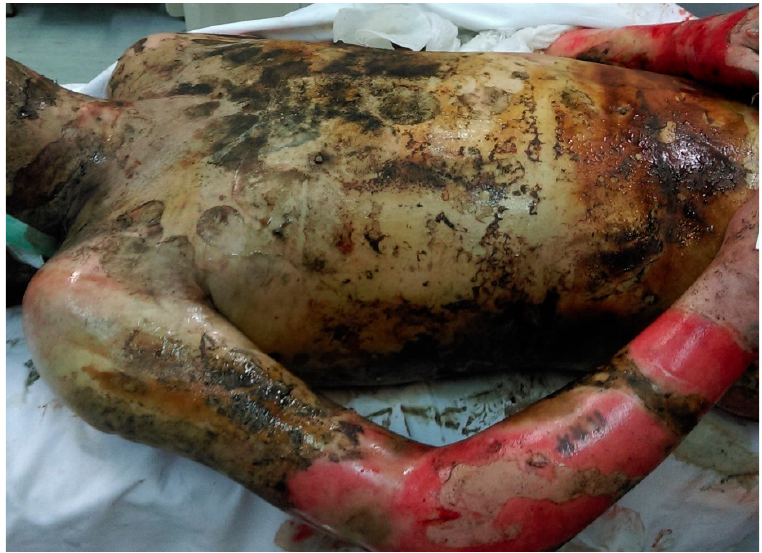
Figure 1. A full-thickness 3rd degree thermal